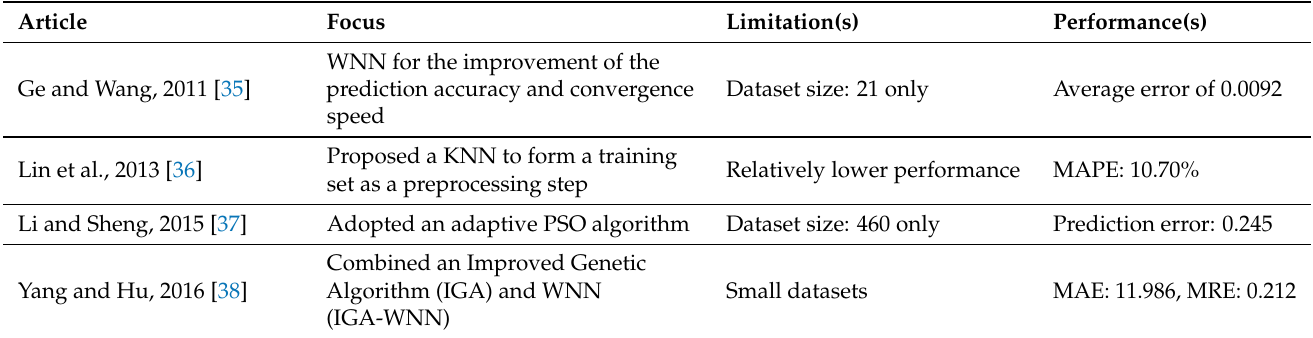
Table 3. Summary of the works found using